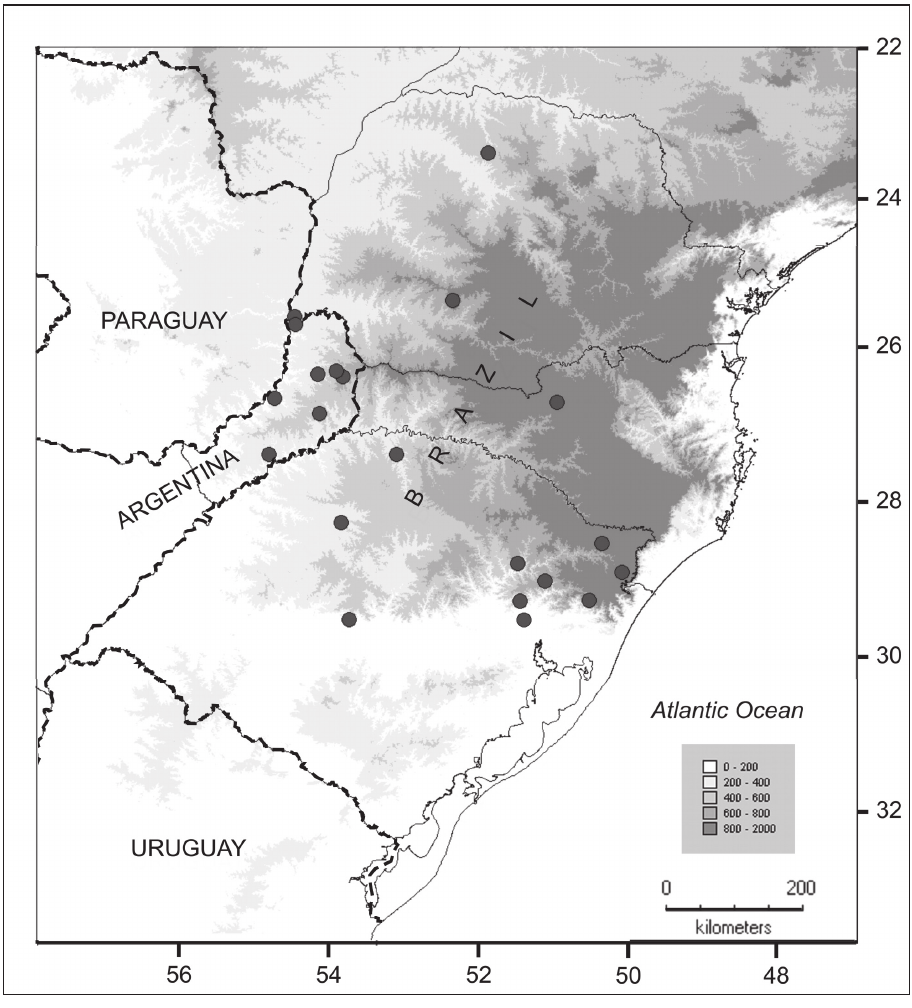
Figure 4. Distribution of Solanum neei in Argentina and Brazil